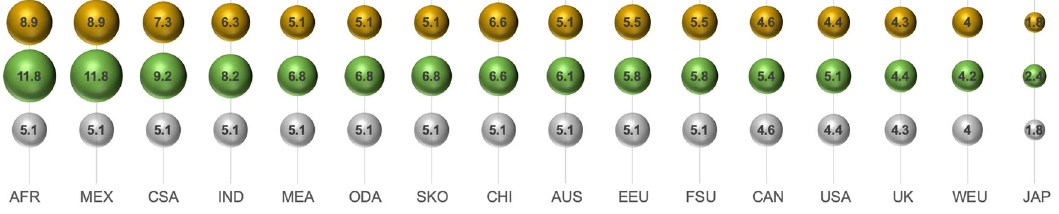
Fig. 2 Low-carbon, high-carbon and reduced WACC values across the TIAM-UCL regions. The bubble size and colour re fl ect the different WACC values for low-carbon (green), high-carbon (brown) technologies, and reduced values (grey). The regions represented are: Africa (AFR), Australia (AUS), Canada (CAN), China (CHI), Central and South America (CSA), Eastern Europe (EEU), Former Soviet Union (FSU), India (IND), Japan (JAP), Mexico (MEX), Middle-east (MEA), Other Developing Asia (ODA), South Korea (SKO), United Kingdom (UK), USA (USA), Western Europe (WEU). For the de fi nition of low-carbon and high-carbon technologies, please refer to Supplementary Table